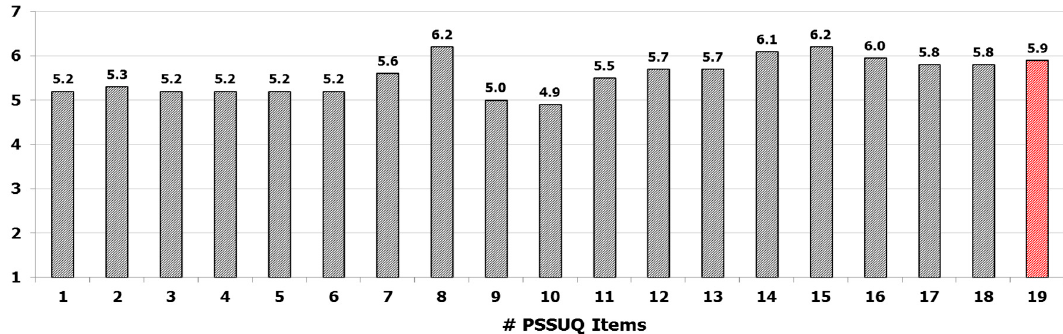
Figure 5. Results of the post-study system usability questionnaire (PSSUQ) on the system usability. The average scores on PD users are indicated for each item. The last column (red) indicates the overall average score assigned to the system and represents the satisfaction of the users. The values for items 6,7,16 and 17 are the average scores assigned separately to upper limbs and lower limbs subsystems.